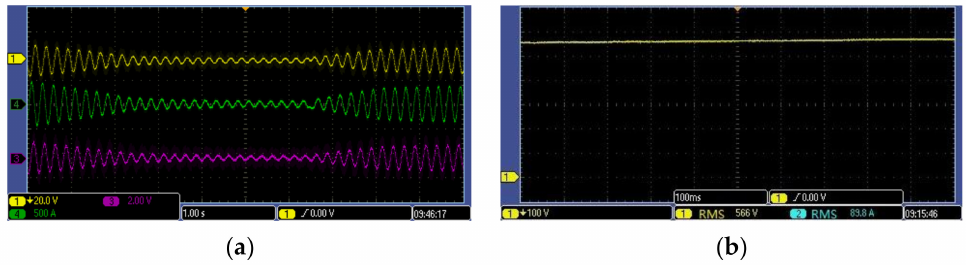
Figure 13. Experimental results in the normal operation. ( a ) the output currents; ( b ) the DC side voltage.